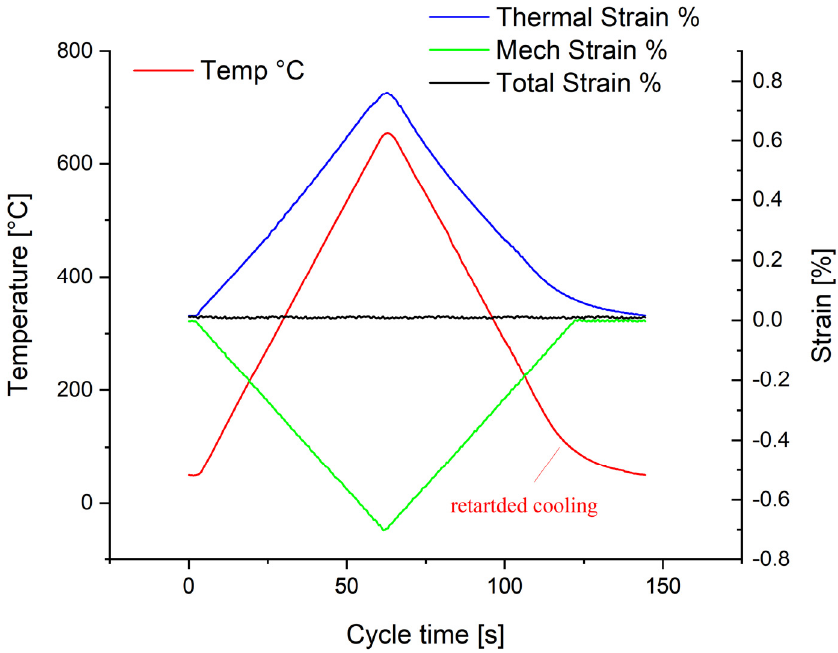
Figure 3. Schematic representation of an out-of-phase thermomechanical fatigue cycle with full (100%, i.e., ε mechanical = −ε thermal ) obstruction of thermal expansion ( Δ T = 50–650 °C, dT/dt = 10 K/s).